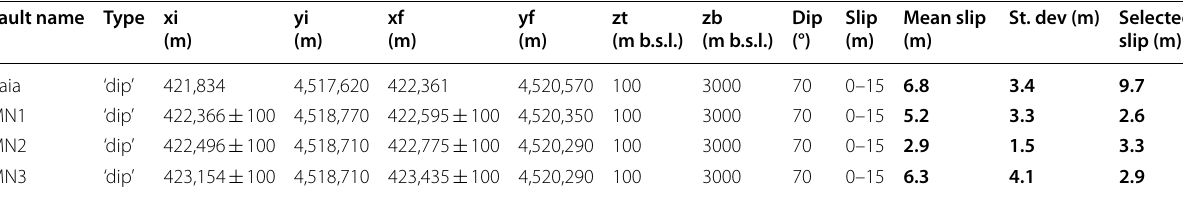
Table 2 Okada92 model fault parameters and results of the Monte Carlo simulation Fault name Type xi